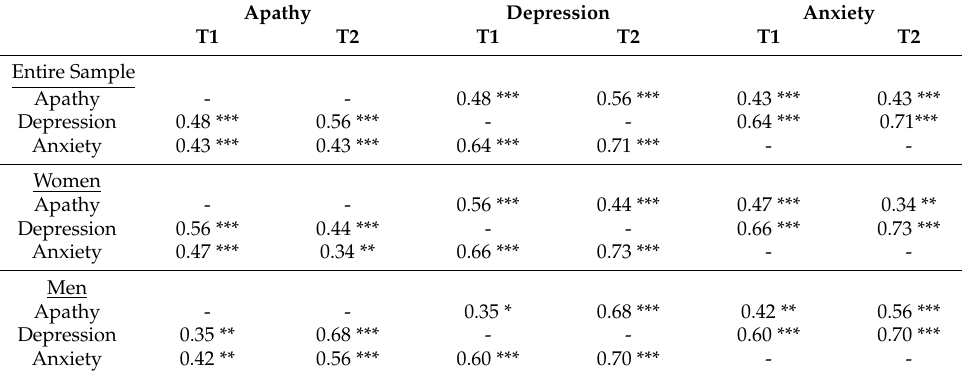
Table 3. Correlations among apathy, depression, and anxiety at T1 and T2 for entire sample, women, and